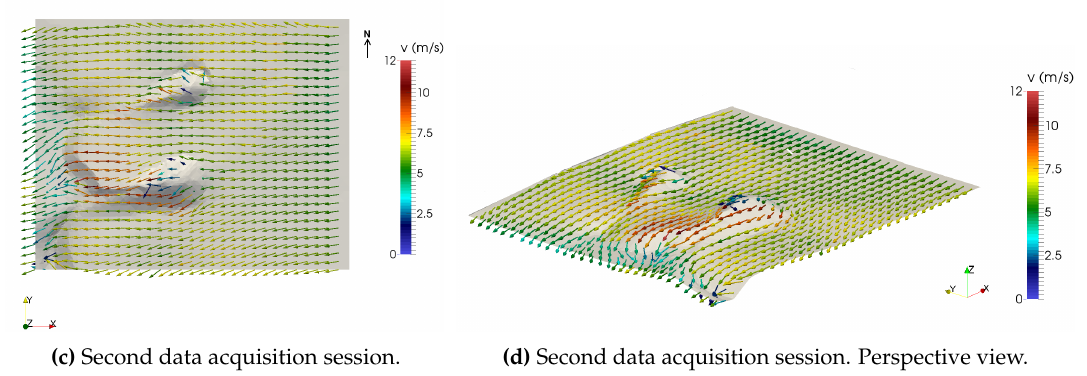
Figure 18. Wind model results for a given instant t with the collected data in both data acquisition